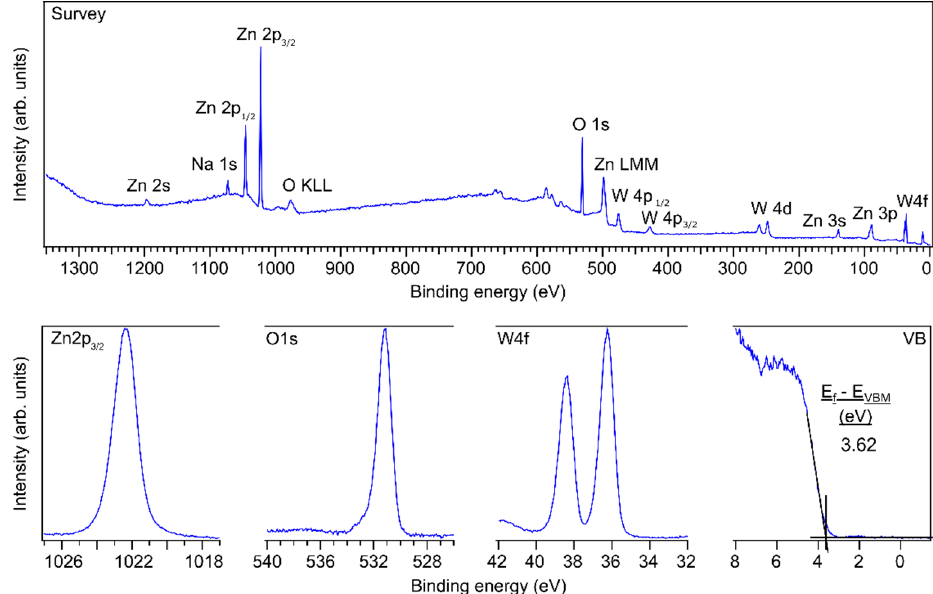
Figure 3. Raman spectrum of 100 nm monoclinic ZnWO 4 thin films annealed in air at 600 ◦ C for 10 h.